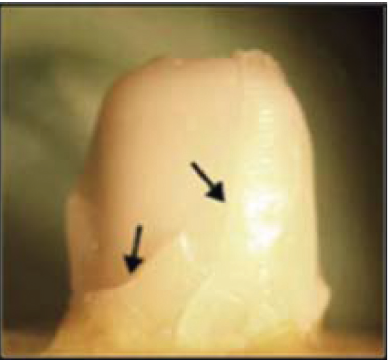
Figure 20: Mode III (bulk fracture) in all-ceramic specimen. Table 5: Two-way analysis of variance (ANOVA) test of signifi- cance for comparing the mean fracture load by groups, incisal veneering thickness, and modes of fracture. Source F P Group 75.7 0.000 ∗ Thickness 14.6 0.003 ∗ Modes of fracture 1.2 0.344 Group ∗ thickness 0.5 0.494 Group ∗ fracture 0.2 0.634 Thickness ∗ fracture 0.3